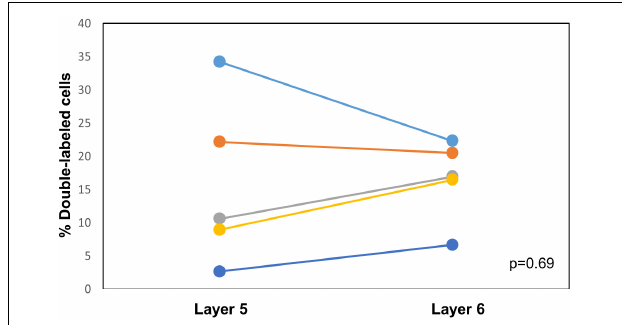
FIGURE 4 | Comparison of the proportion of double-labeled cells found in each layer after injection of different tracers into the left and right IC. See Table 2 for actual values. n = 5 mice. p -value calculated using Wilcoxon Signed Rank Test. Each color corresponds to a different mouse.